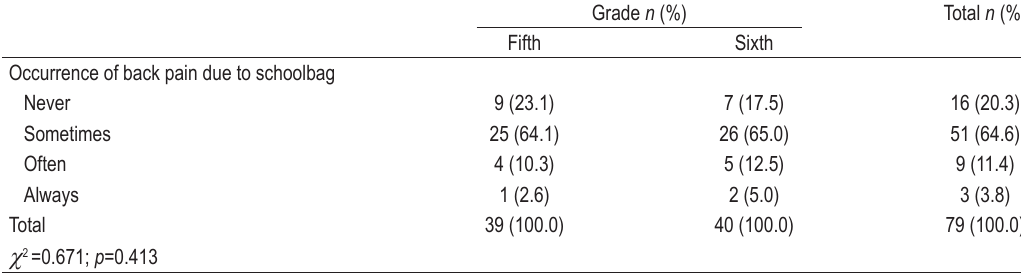
TABLE 5. Occurrence of schoolbag ‑related back pain in the last 4 weeks